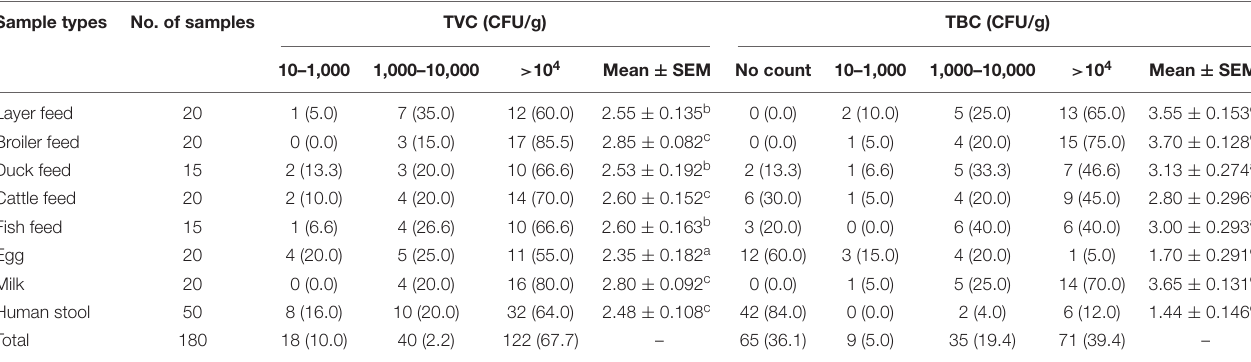
TABLE 3 | Enumeration of TVC and TBC in different feed and other samples. Sample types No. of samples